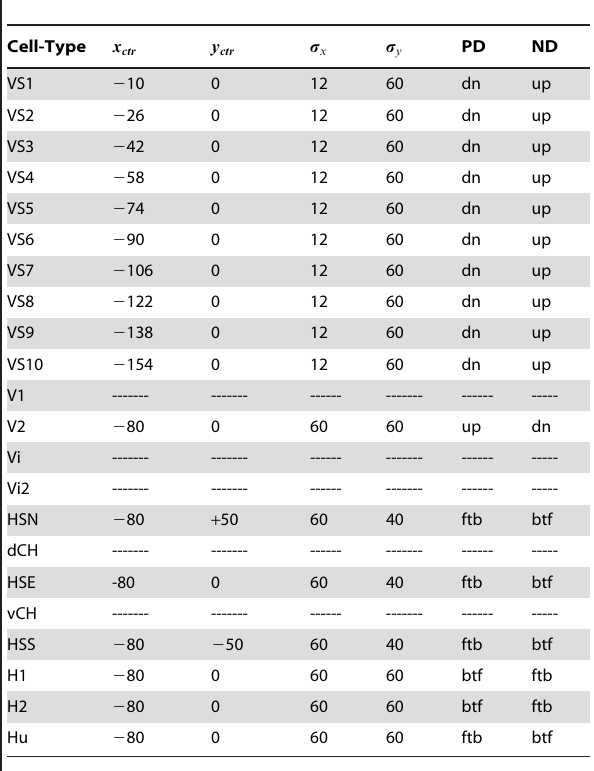
Table 2. Receptive fields of the simulated tangential cells.